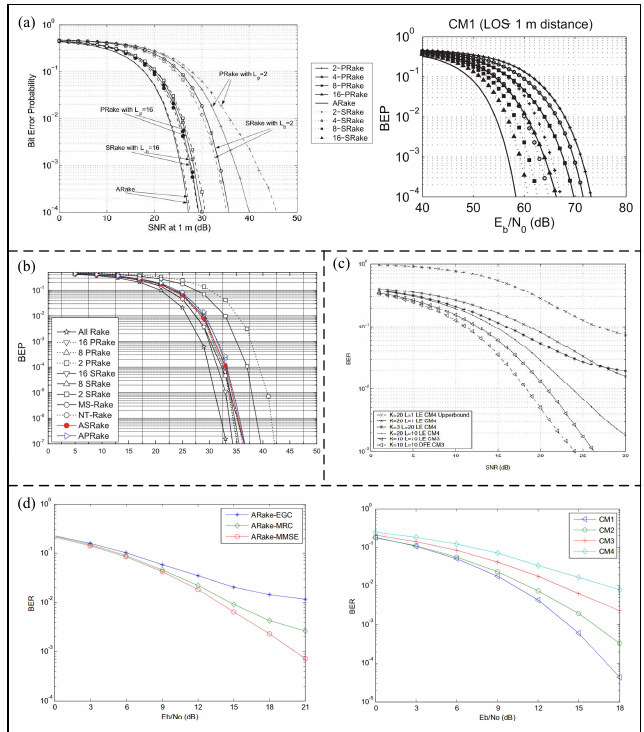
Figure 8. ( a ) Functional between BEP and normalized SNR at rake output of A−rake, S−rake, and P−rake in LF channel. The BEP vs. Eb/N0 for P−Rake and S−Rake in the HF channel model with the full transmission bandwidth. (Reprinted from [53], Copyright 2007, with permission from IEEE). ( b ) BEP for the case of the LF channel model. (Reprinted from [54], Copyright 2012, with permission from Springer). ( c ) UWB rake−MMSE−equalizer structure and performance of UWB rake−MMSE−receiver for different number of equalizer taps and rake fingers. (Reprinted from [55], Copyright 2005, with permission from IEEE). ( d ) BER comparison of three combining methods for Rake in CM3 and the BER performance of the proposed Rake−MMSE receiver under CM1−CM4 channel models. (Reprinted from [56], Copyright 2016, IEEE).